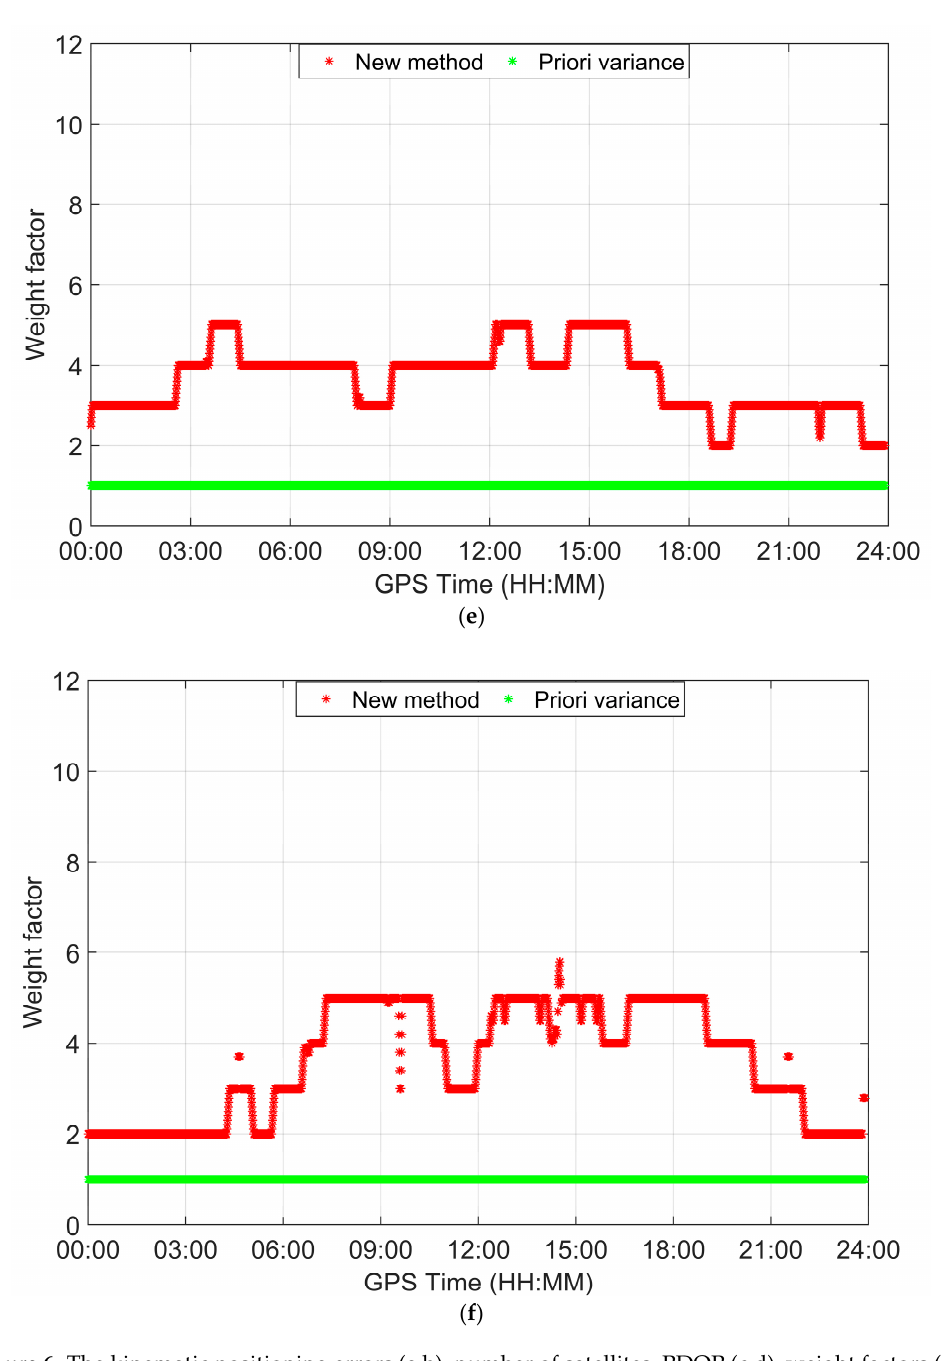
Figure 6. The kinematic positioning errors (a,b), number of satellites, PDOP (c,d), weight factors (e,f) of dual-frequency by station MAT1 ( a,c,e ) and single-frequency by station KRGG ( b,d,f ). Table 4. Kinematic RT PPP for three processing methods.